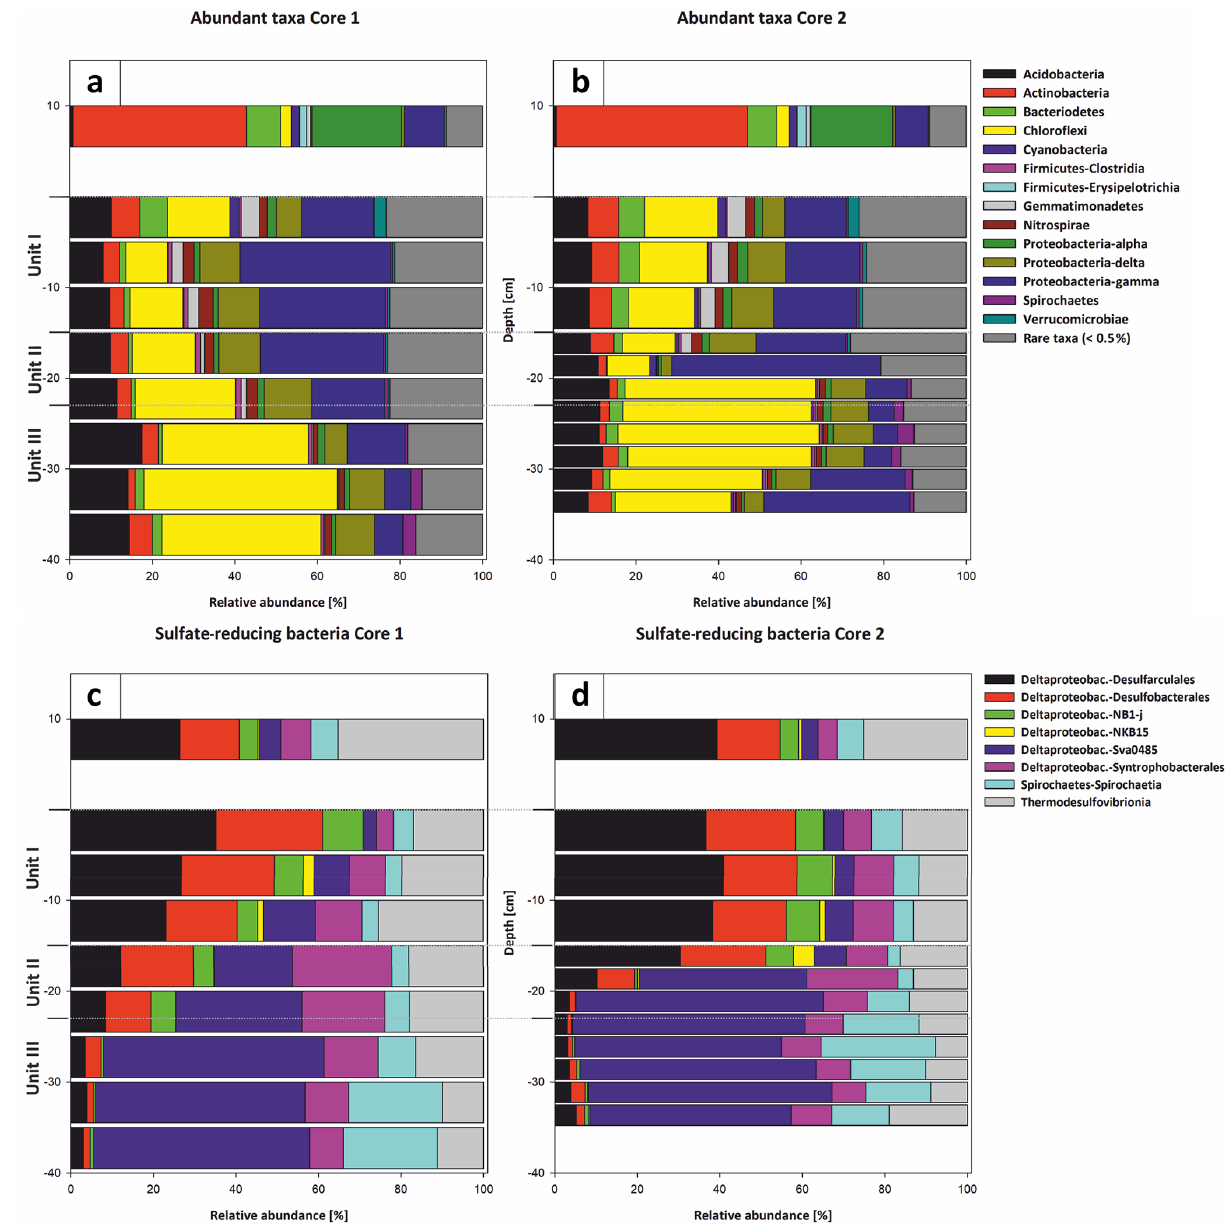
Figure 11. Most abundant taxa in Core 1 (a) and Core 2 (b) . The legend indicates all abundant taxa on the phylum level, including the class level for Proteobacteria and Firmicutes. All orders below 0.5% relative abundance were summarized as rare taxa. The abundant taxa change at the transitions from water column to sediment and the lithological units (I–III). The taxonomic composition of sulfate reducers in Core 1 (c) and Core 2 (d) changes gradually from Unit I–II and more pronouncedly from Unit II–III. Sulfate reducers are shown on the class and order level. The column thickness relates to the sampled increments of either 5 or 2.5cm. Sulfate reducers represent up to 15% of the total bacterial community and were normalized to 100% relative abundance to illustrate the changes within their